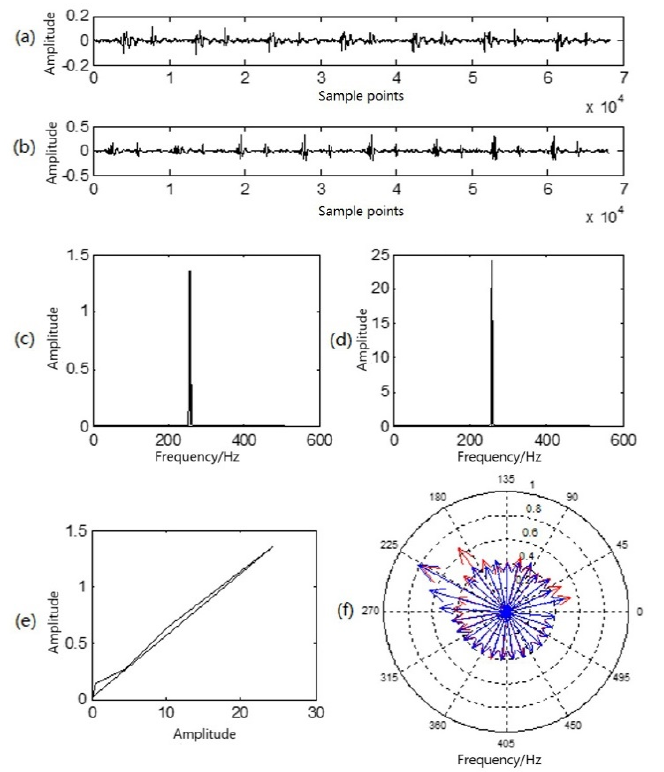
Figure 4. Multi-characteristic analysis diagram of a group of heart sounds in a resting state and a state of motion: ( a ) resting heart-sound signals; ( b ) in-motion heart-sound signals; ( c ) sound-direction vector of resting heart sounds; ( d ) sound-direction vector of heart sounds in motion; ( e ) similarity phase diagram of at-rest and in-motion heart sounds; ( f ) P–P–F heart sounds for at-rest heart sounds (red) and heart sounds in motion (blue).